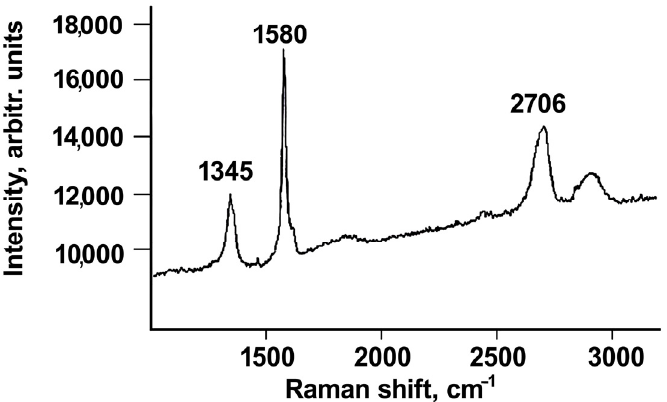
Figure 1. Raman spectrum of graphene in AlMnGr composite.